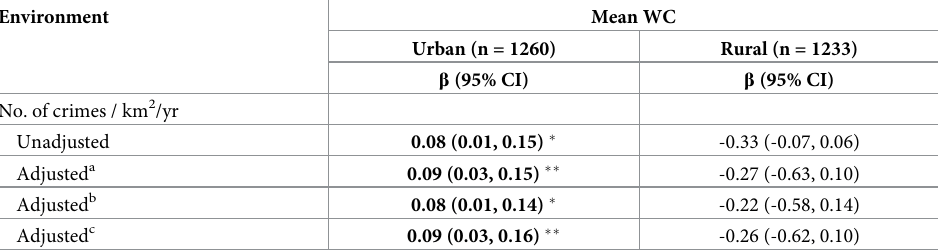
Table 5. Urban-rural-specific unadjusted and adjusted β coefficients (Confidence Intervals in brackets) for the association of no. of crimes / km 2 /yr with mean waist